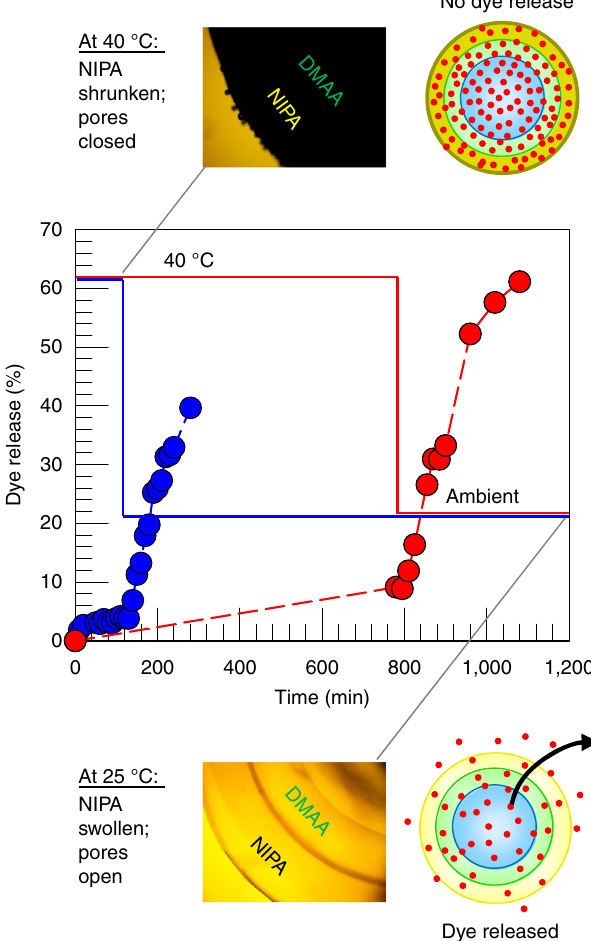
Fig. 6 Temperature-responsive release of dye from a two-layer DMAA – NIPA capsule. Here, DMAA is the inner layer and NIPA is the outer layer. At 40 °C (above the LCST of NIPA), the pores in the outer NIPA layer are closed; thus, the dye remains in the capsule. This is indicated by the schematic, and the corresponding micrograph shows a dark capsule due to the turbidity of the outer layer. After a certain time (110 min for the blue curve ; 780 min for the red curve ), the temperature is lowered to ambient (25 °C). The pores in the NIPA layer open up, causing the dye to release. This is shown by the schematic, and in this case the micrograph shows a transparent capsule. The y -axis is normalized to the dye released into solution after a long time (2